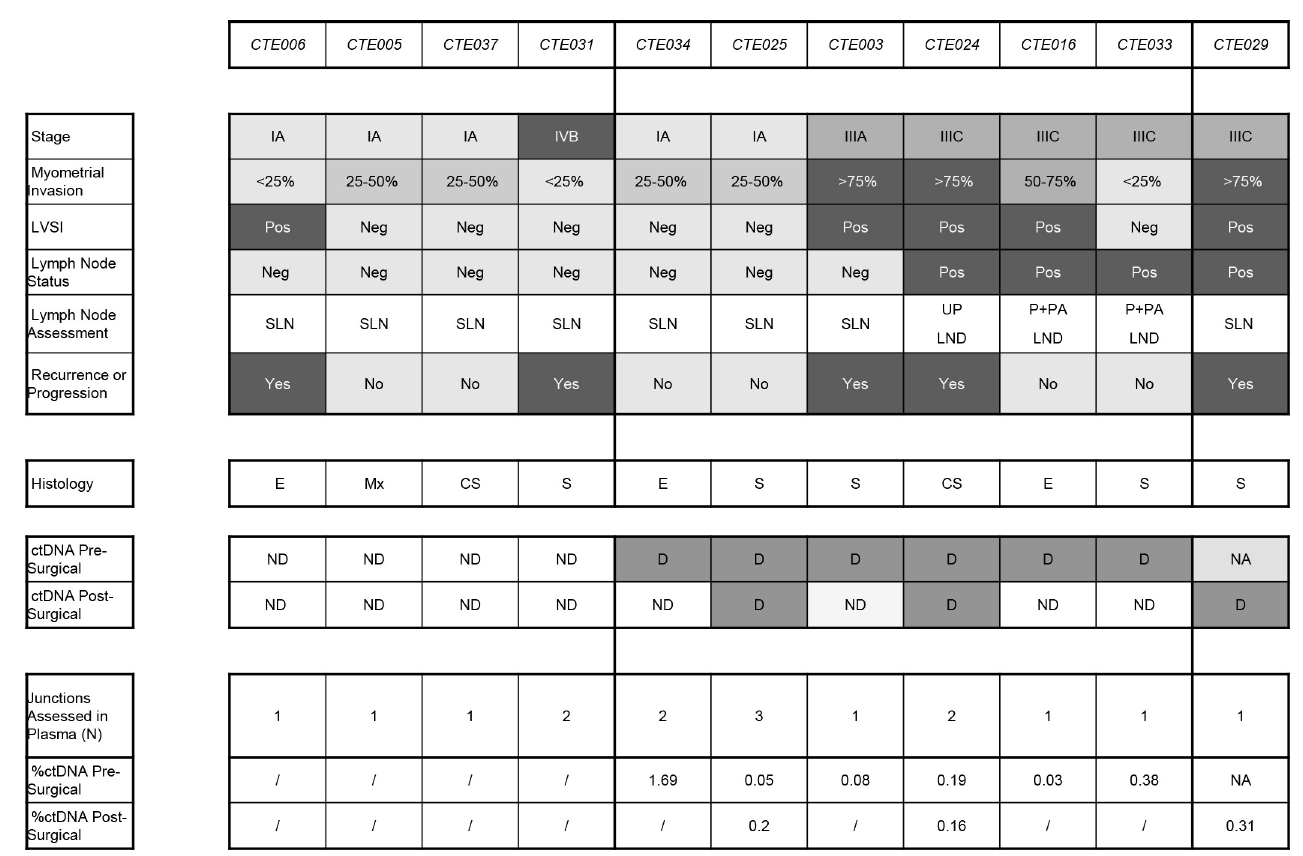
Fig 4. Heat map characterizing and correlating clinical findings to the presence or absence of detected circulating tumor DNA (ctDNA). Abbreviations: CS, carcinosarcoma; D, detected; E, endometrioid; G, grade; LVSI, lymphovascular space invasion; Mx, Mixed; NA, not available; ND, not–detected; Neg, negative; P + PA LND, pelvic + para–aortic lymphadenectomy; Pos, Positive; S, Serous; UP LND, unilateral pelvic lymphadenectomy.